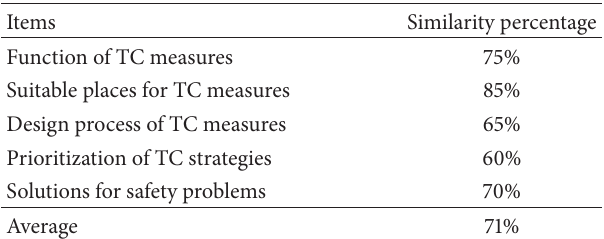
Table 8: Summary of percentage of similarity between evaluators’ responses and those of the